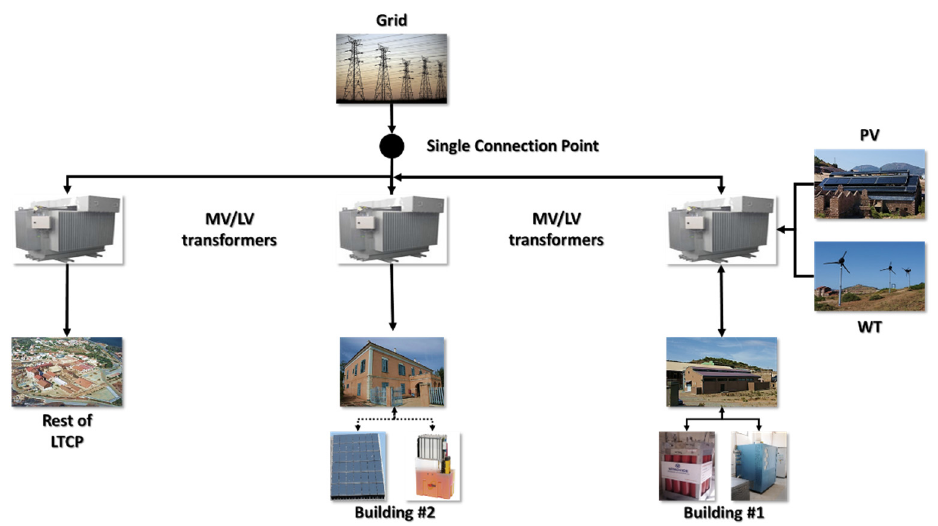
Figure 4. Electrical grid configuration of LTCP.